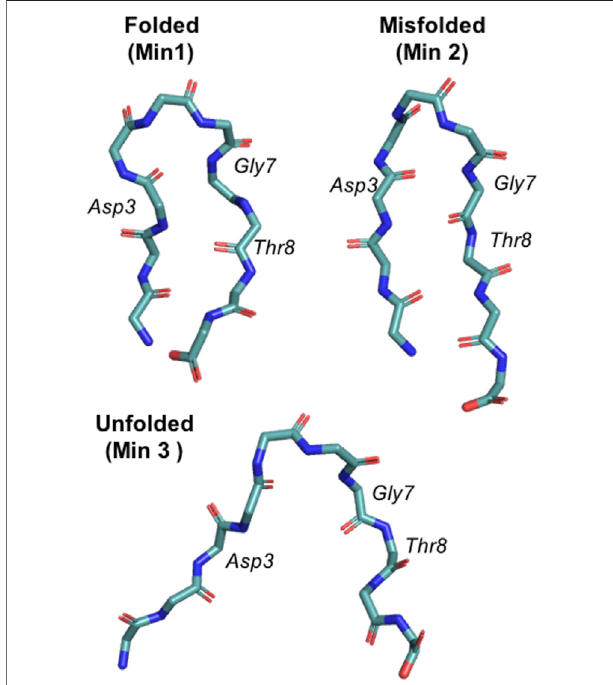
FIGURE 1 | Representation of the three main chignolin minima corresponding to the folded (Min 1), misfolded (Min 2) and unfolded (Min 3)